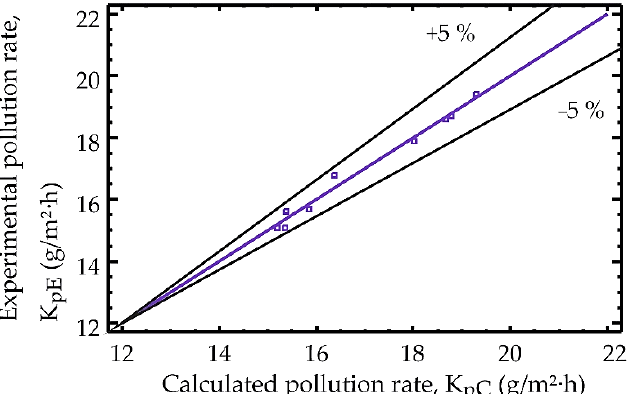
Figure 8. Comparison of calculated pollution rate K pC values with experimental K pE during the fuel oils combustion.